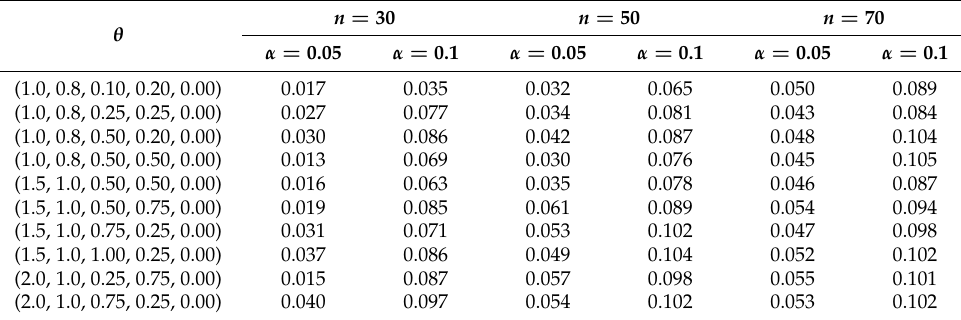
Table 7. Simulation results for the probability of type I error for a 1 = 5 and a 2 =